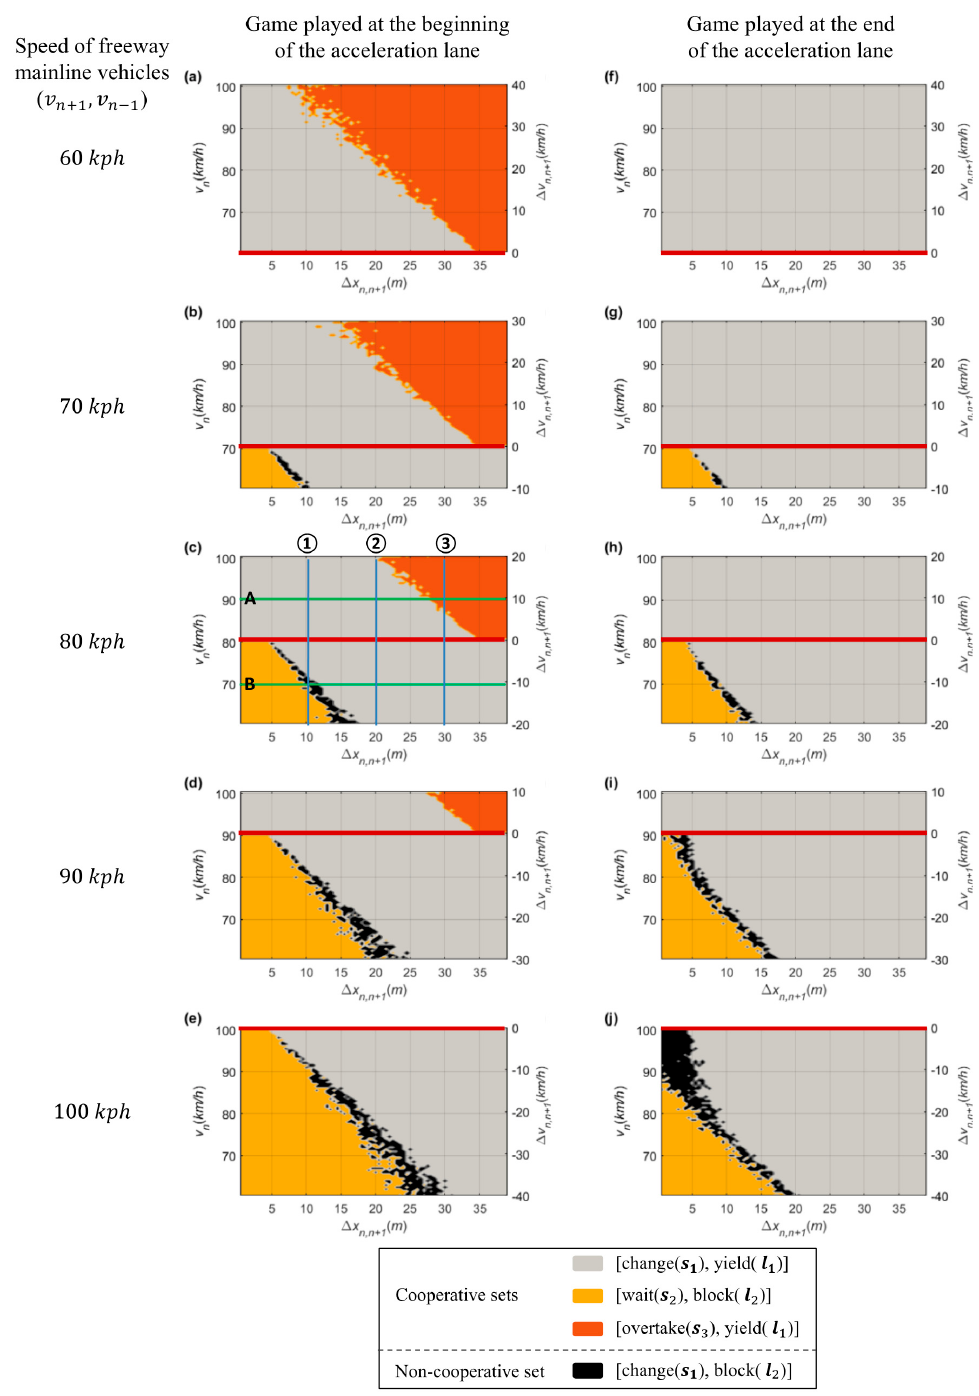
Figure 9. Graphical representation of the one-shot game results depending on game locations, spacing between vehicles ( ∆ x n , n + 1 ), and speed of the SV ( v n ): ( a–e ) game played at the beginning of the acceleration lane with mainline vehicles driving at 60 km / h to 100 km / h, respectively; ( f–j ) game played at the end of the acceleration lane with mainline vehicles driving at 60 km / h to 100 km / h, respectively. Note that a red line parallel to the x-axis on each graph indicates the speed of the freeway mainline vehicles ( v n − 1 , v n + 1